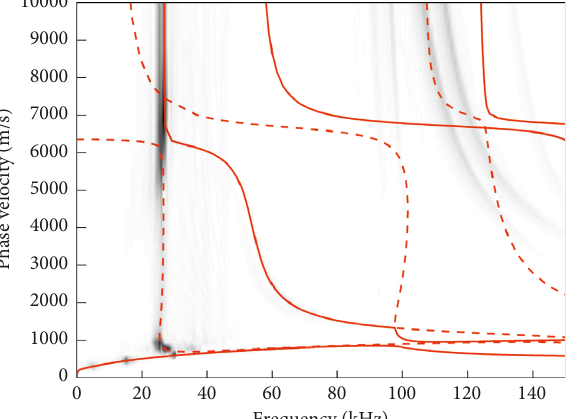
Figure 3: A comparison of the dispersion curves of the sandwich plate and the model’s response in the frequency-wavenumber domain (the solid red lines are the asymmetric modes, and the dotted red lines are the symmetric